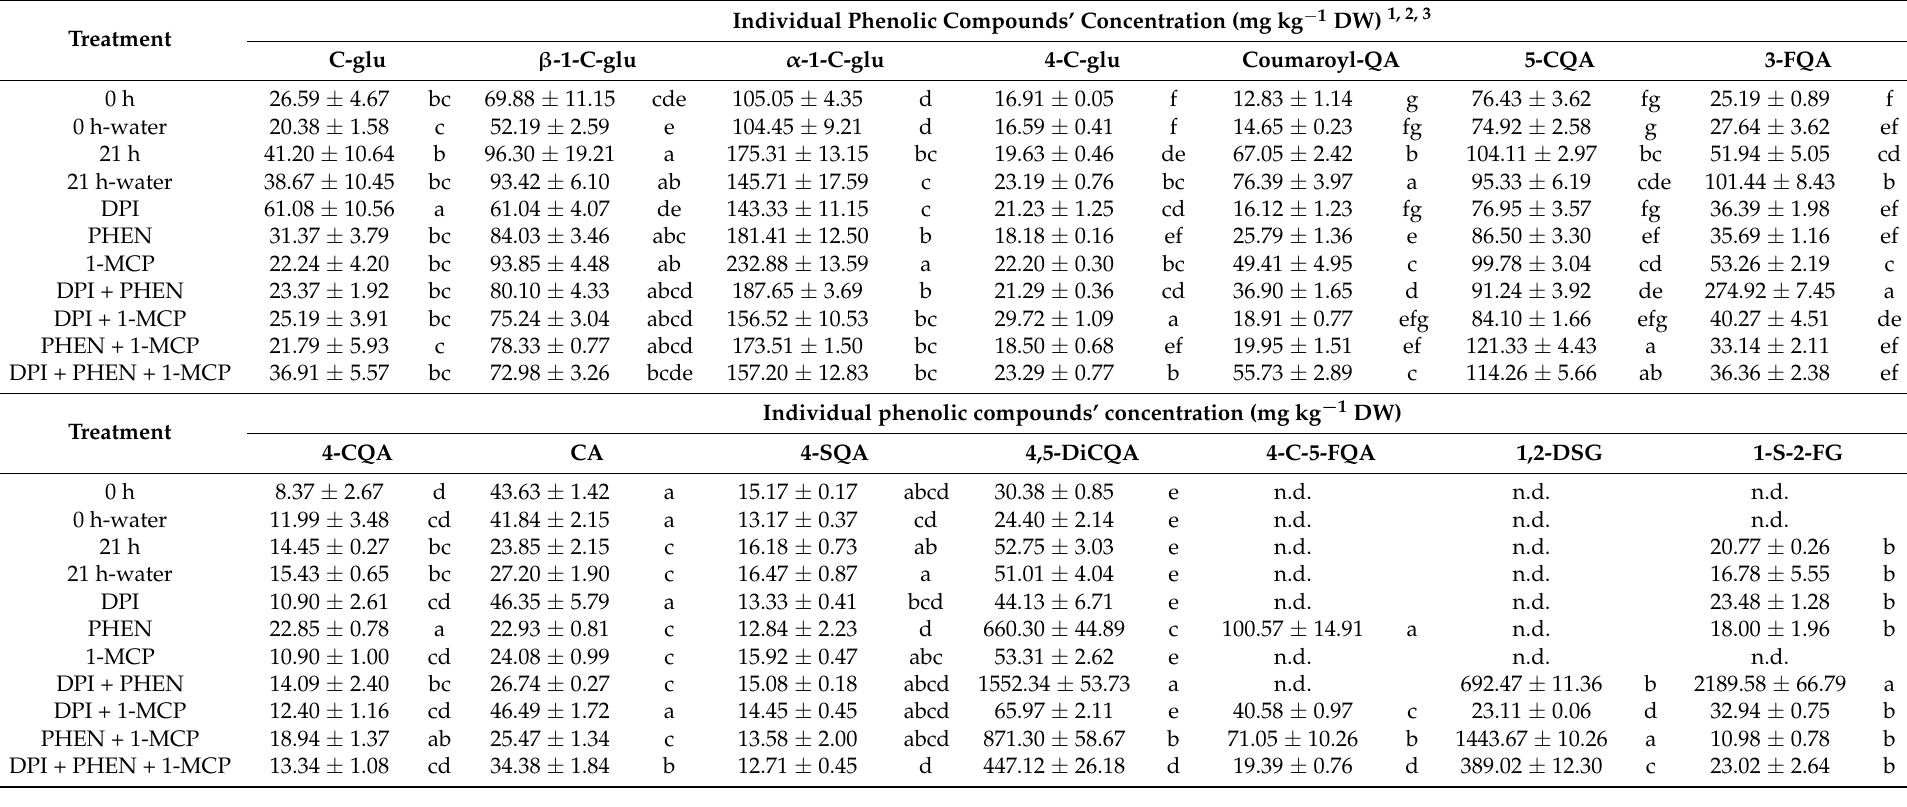
Table 1. Effect of diphenyleneiodonium chloride (DPI), phenidone (PHEN), and 1-methylcyclopropene (1-MCP) on the wound-induced accumulation of individual phenolic compounds in